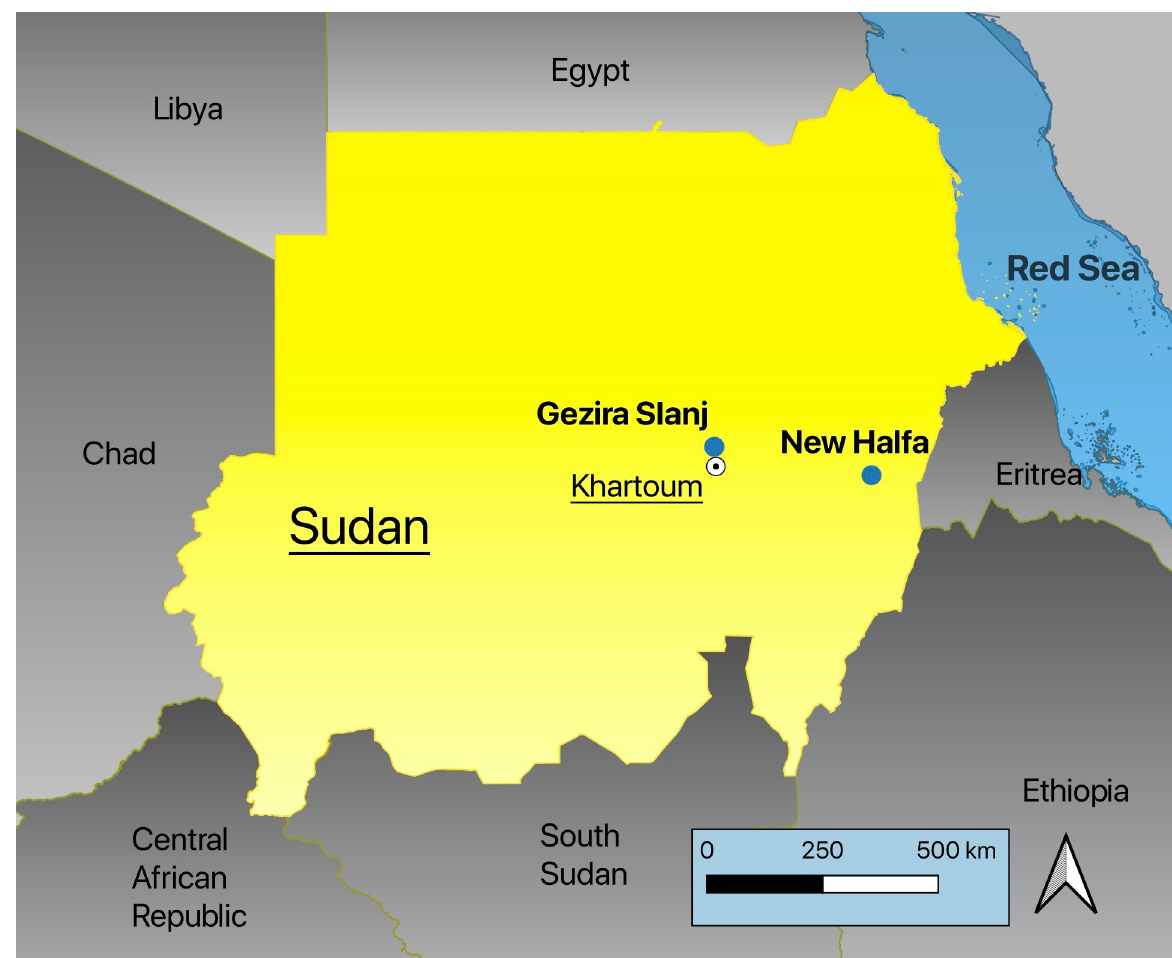
Fig 1. Location of G6PD study sites, 2015, Sudan. Map produced in QGIS [QGIS Development Team, 2021. QGIS Geographic Information System. Open-Source Geospatial Foundation. http://qgis.org]; basemaps [https://www.diva-gis.org/Data] and [Flanders Marine Institute